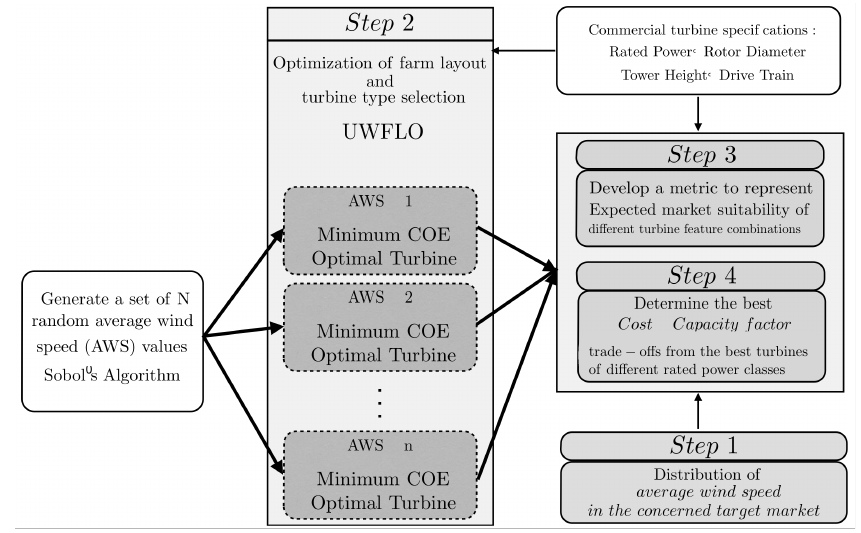
Figure 1. Overall framework for exploring “turbine-wind regime” compatibilities.